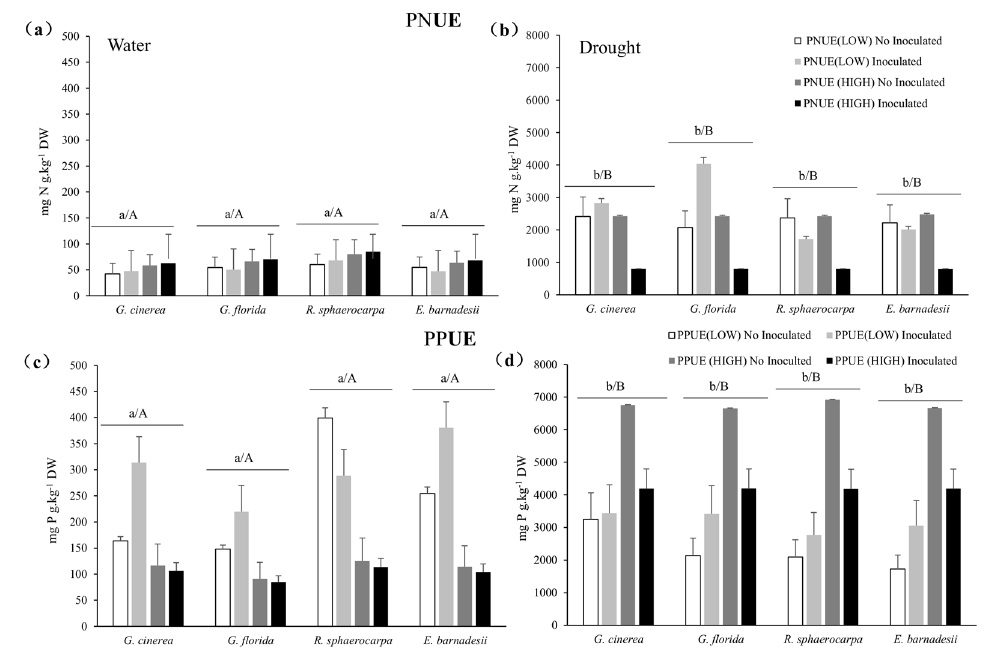
Figure 7. Nitrogen and Phosphorus physiological use efficiencies (PNUE and PPUE) of G. cinerea , G. florida , E. barnadesii and R. sphaerocarpa after receiving either 500 µM (High P) or 5 µM (Low P) nutrient solutions with and without rhizobial inoculations under two water regimes (water: well-irrigated plants ( a ), ( c ); drought: water-stressed plants ( b ), ( d ). Values are presented as means ( n = 13–15) with standard error bars. Upper case letters indicate significant differences between water treatments and lower case letters indicate significant differences among inoculation treatments using the post-hoc Fisher’s LSD, multiple range test ( p ≤ 0.05).